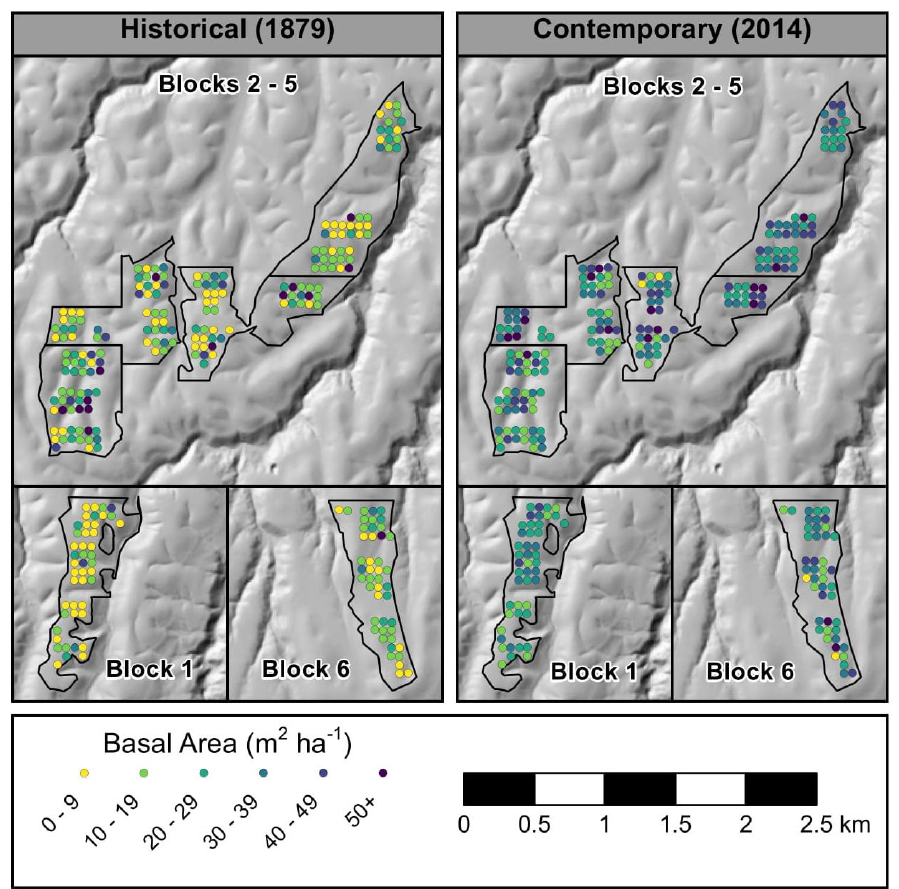
Figure 4. Maps of historical ( left ) and contemporary ( right ) basal area. Comparison between the two panels shows an increase in plot–level basal area and spatial homogeneity from 1879 to 2014.